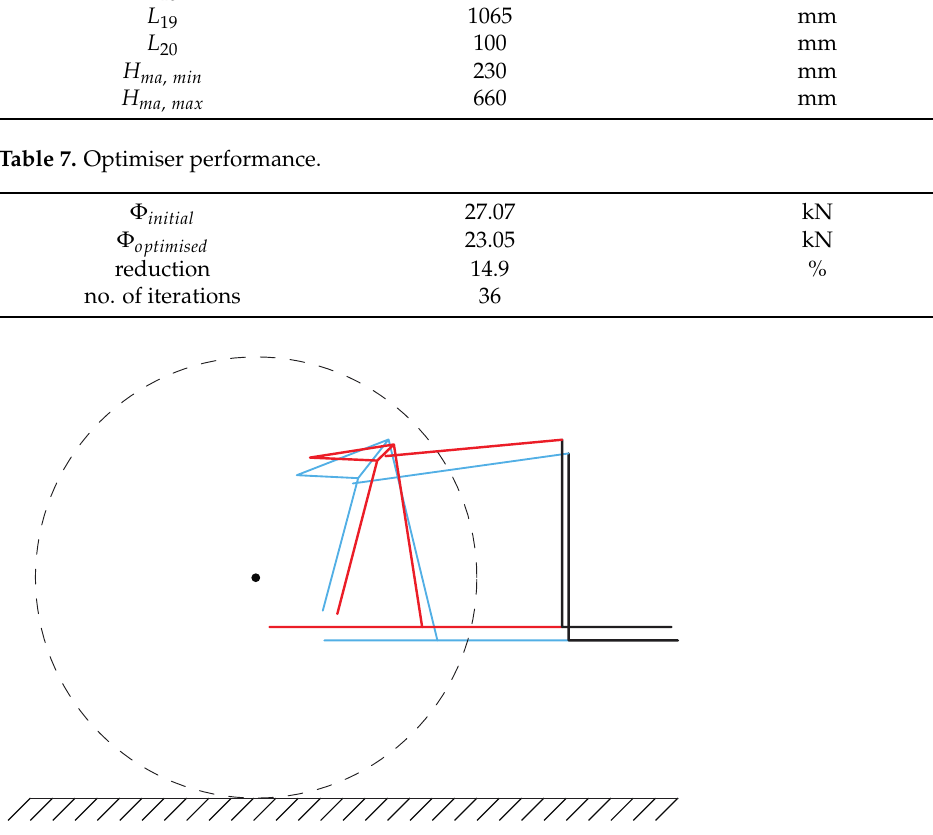
Figure 13. Comparison between the initial (blue lines) and optimised (red lines) TPH geometry.